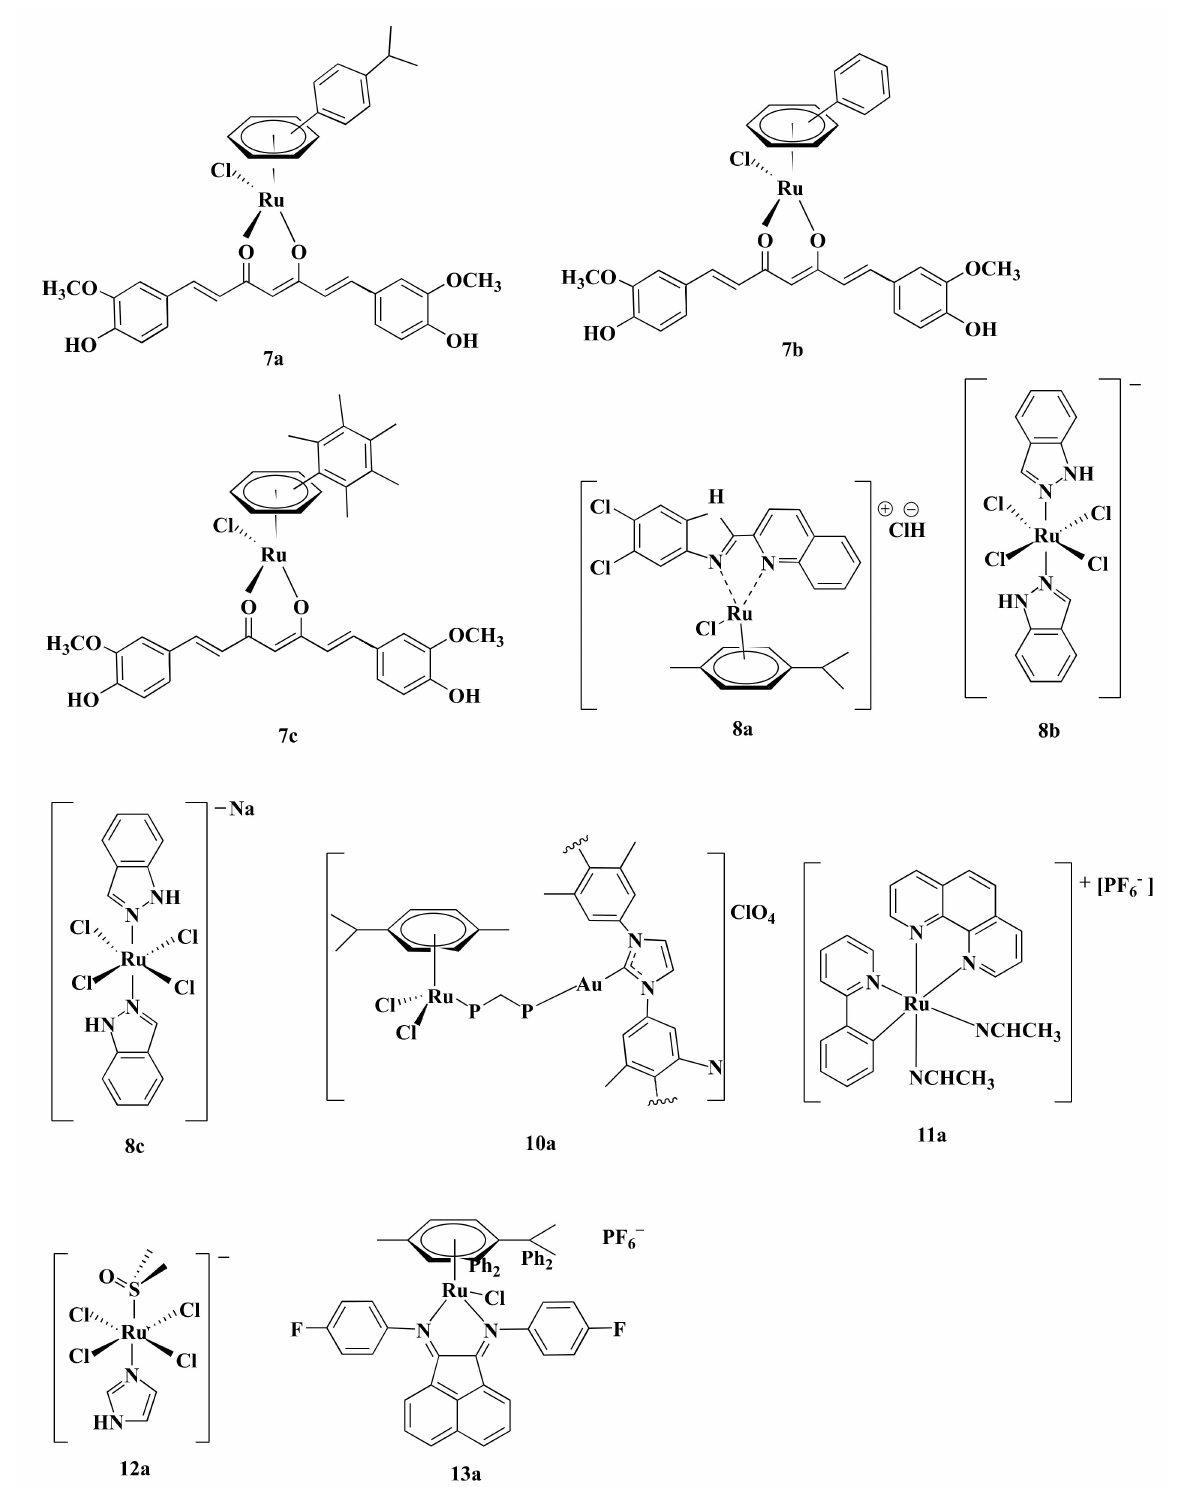
Figure 6. Structures of some Ru-complexes using in CRC treatment. Different Ru-complexes mediated apoptosis of CRC cells via inhibiting proteasome activity ( 7a – c ), ROS-mediated apoptosis ( 8a – c ), inhibiting thioredoxin reductase activity ( 10a ), inhibiting HIF-1 pathway ( 11a ), anti-metastasis activity ( 12a ), and lysosomal dysfunction ( 13a